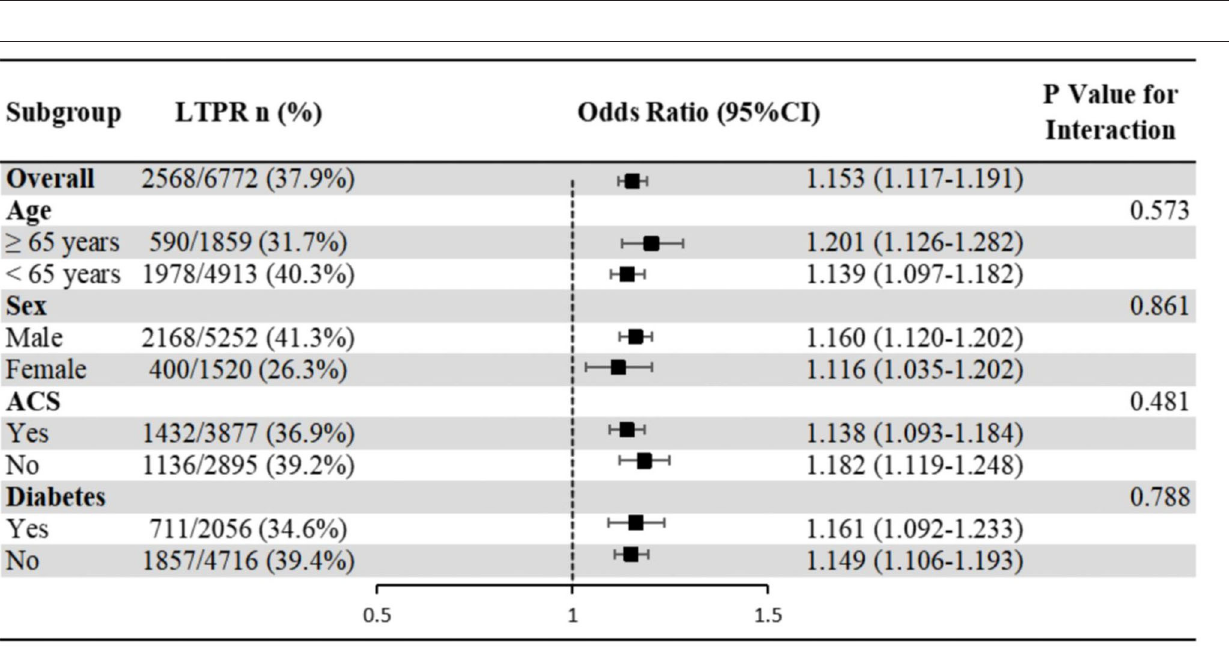
FIGURE 3 | Subgroup analyses of the association of leukocyte count with LTPR. Odds ratios and 95% confidence intervals are shown for LTPR. P -value represents interaction test between the variable and the leukocyte count. ACS, acute coronary syndrome; LTPR, low on-treatment platelet reactivity.